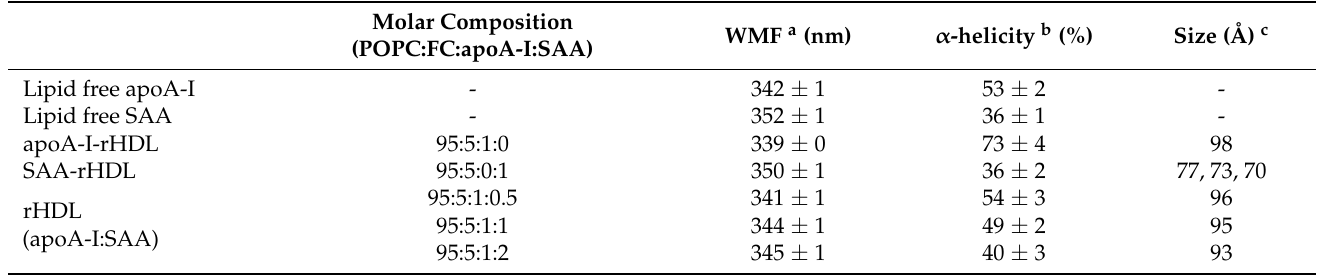
Table 1. Spectroscopic characterization of rHDL containing apoA-I and SAA in the lipid-free and lipid-bound